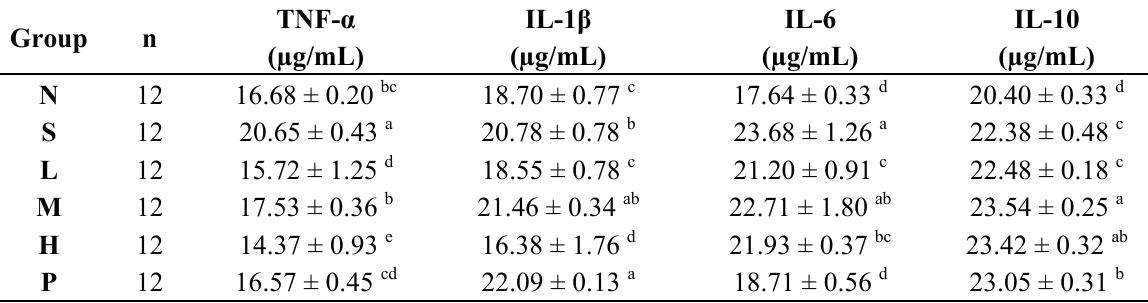
Table 3. Spleen level of inflammatory cytokines concentrations of LPS-induced sepsis mice.